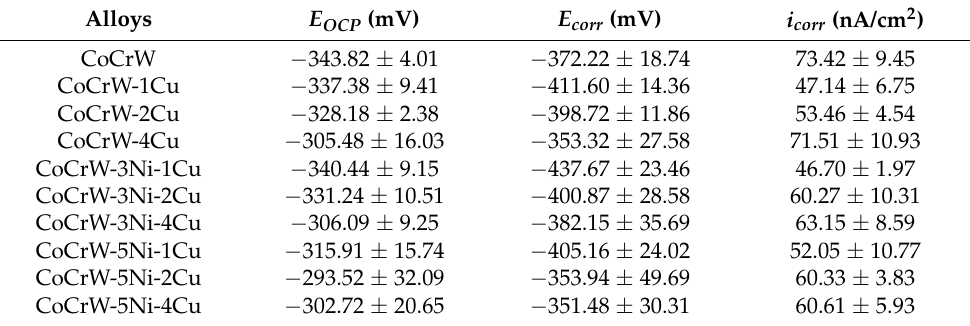
Figure 5. ( a , c , e ) Open-circuit potential (OCP) and ( b , d , f ) Tafel curves of the as-cast CoCrW-xNi-yCu alloys: ( a , b ) CoCrW-yCu, ( c , d ) CoCrW-3Ni-yCu, and ( e , f ) CoCrW-5Ni-yCu alloys. Table 4. Electrochemical data obtained from OCP curves and polarization curves.